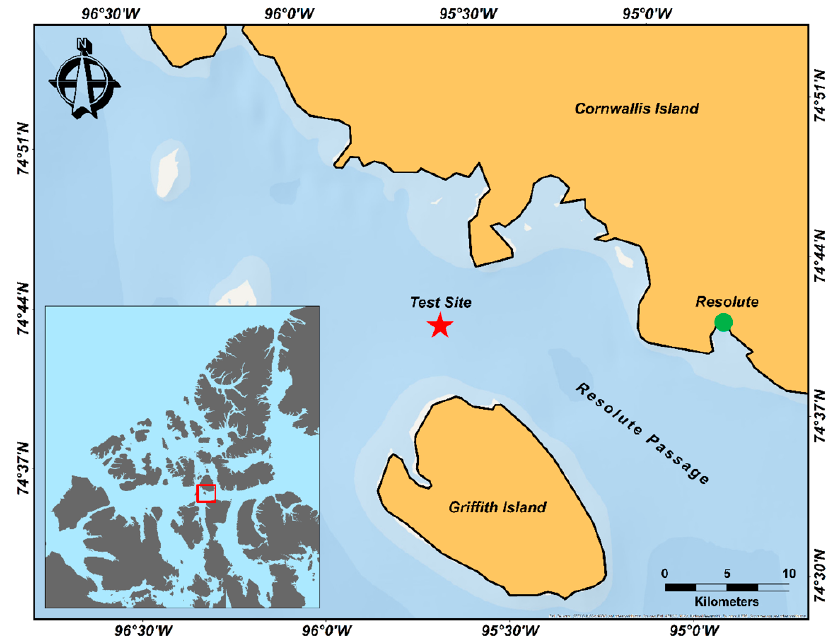
Figure 1. Map of Resolute Bay region (indicated in green dot) in Resolute Passage in the Canadian Arctic, Nunavut, Canada. Study site location is indicated in red star. Snow covered first-year ice accumulated areas are depicted in light blue, and land in brown. Note: A similar figure with different color scheme can be found in [14].